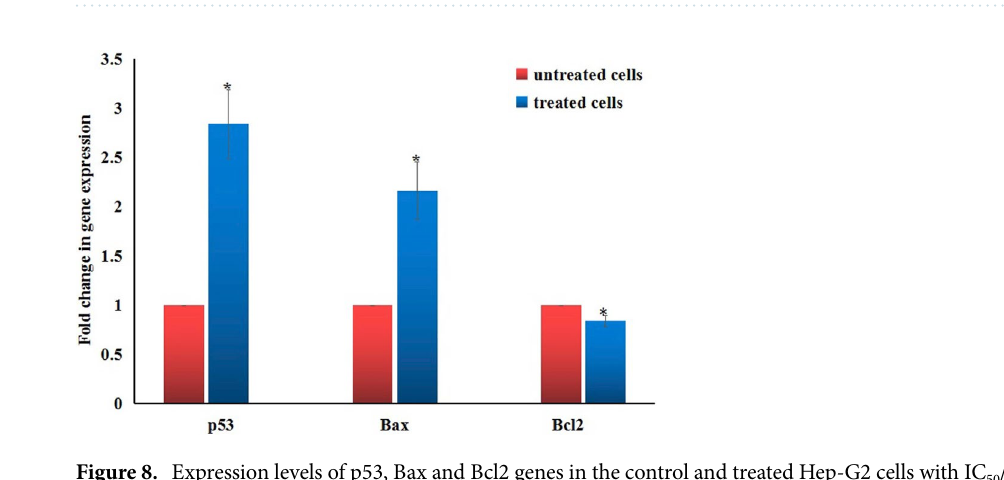
Figure 7. Intracellular ROS generation in the control and treated Hep-G2 cells with IC50/72 h (6.21 µg/ml) of Erbium Oxide nanoparticles.